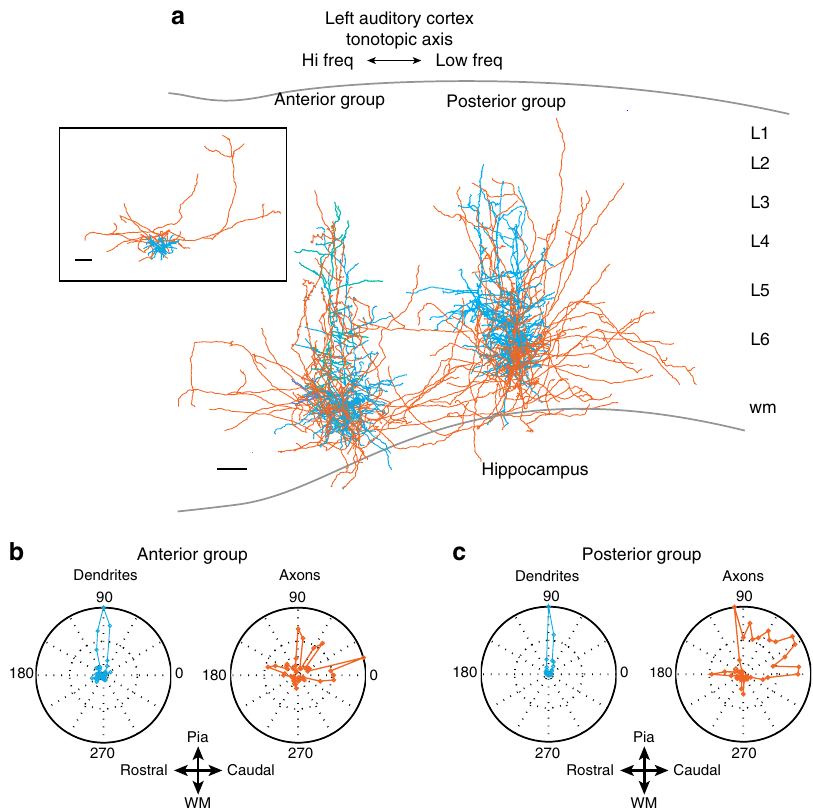
Fig. 5 Axonal arborizations re fl ect circuit-motifs in the left ACx. a Neurolucida reconstructions of L6 pyramidal neurons in anterior ( n = 4) and posterior ( n = 5) regions of the ACx. Dendrites and somata are shown in blue, axons in red. Inset shows one of the cells reconstructed with out-of-column and super fi cial projecting axons. Scale bars 0.1 mm. b , c Polar plots of the processes along the tonotopic axis. 0 degrees = posterior direction, 90 degrees = pia, 180 degrees = anterior, 270 degrees = white